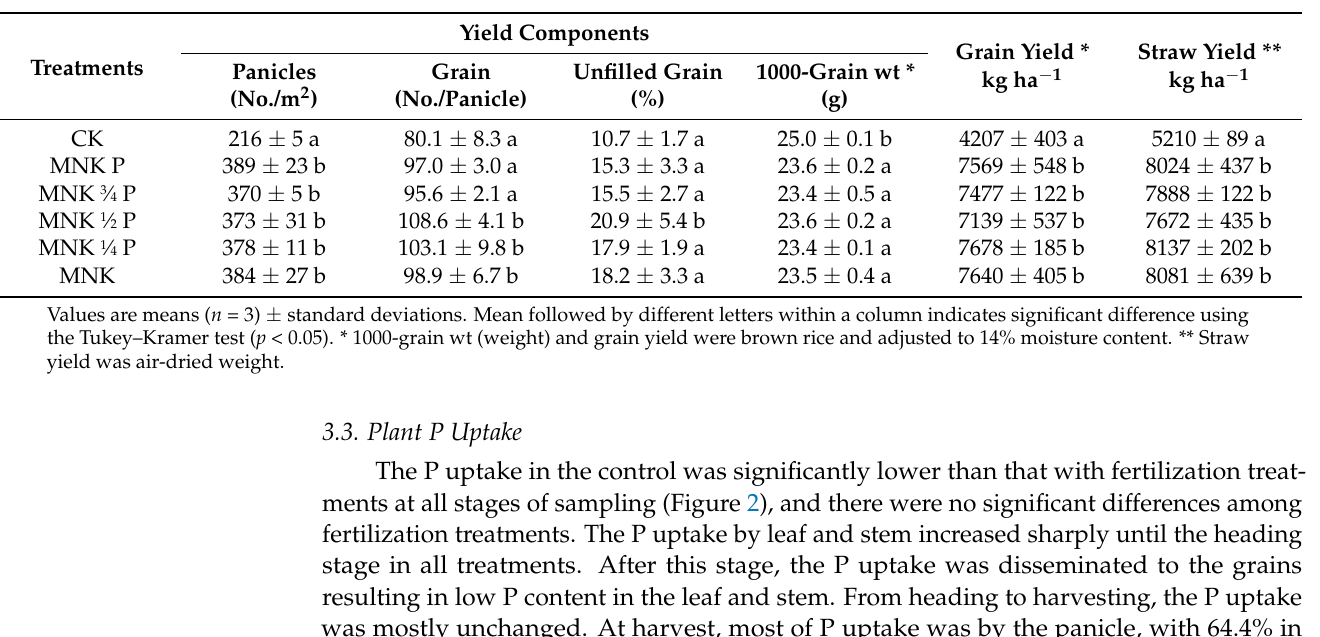
Table 1. Yield components, grain yield, and straw yield of rice response to different levels of chemical P fertilizer application.